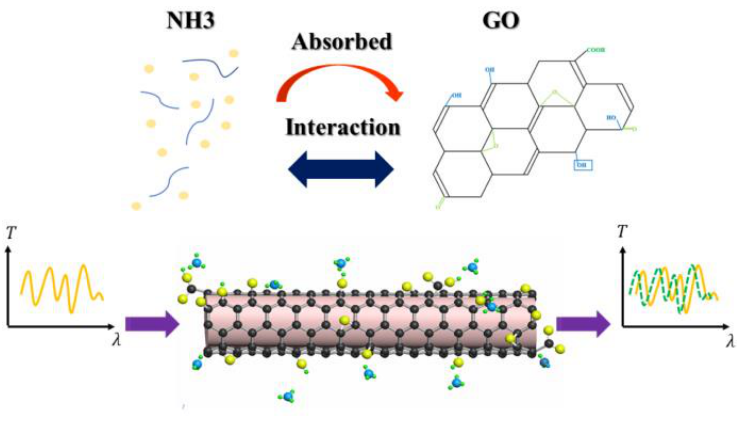
Figure 10. Schematic diagram of NH 3 sensing mechanism ammonia of the sensor coated GO.